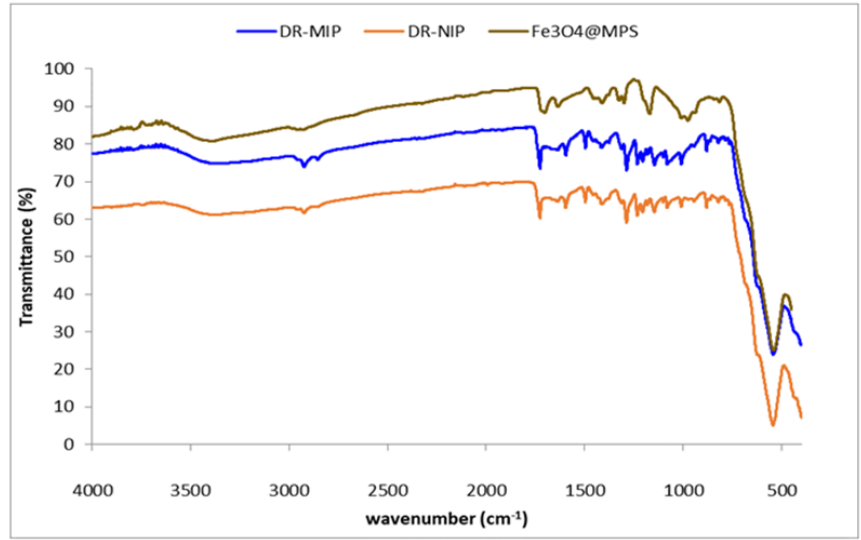
Figure 3. FTIR-ATR spectra of DR-MIP, DR-NIP (non-imprinted polymer) and Fe 3 O 4 @MPS.